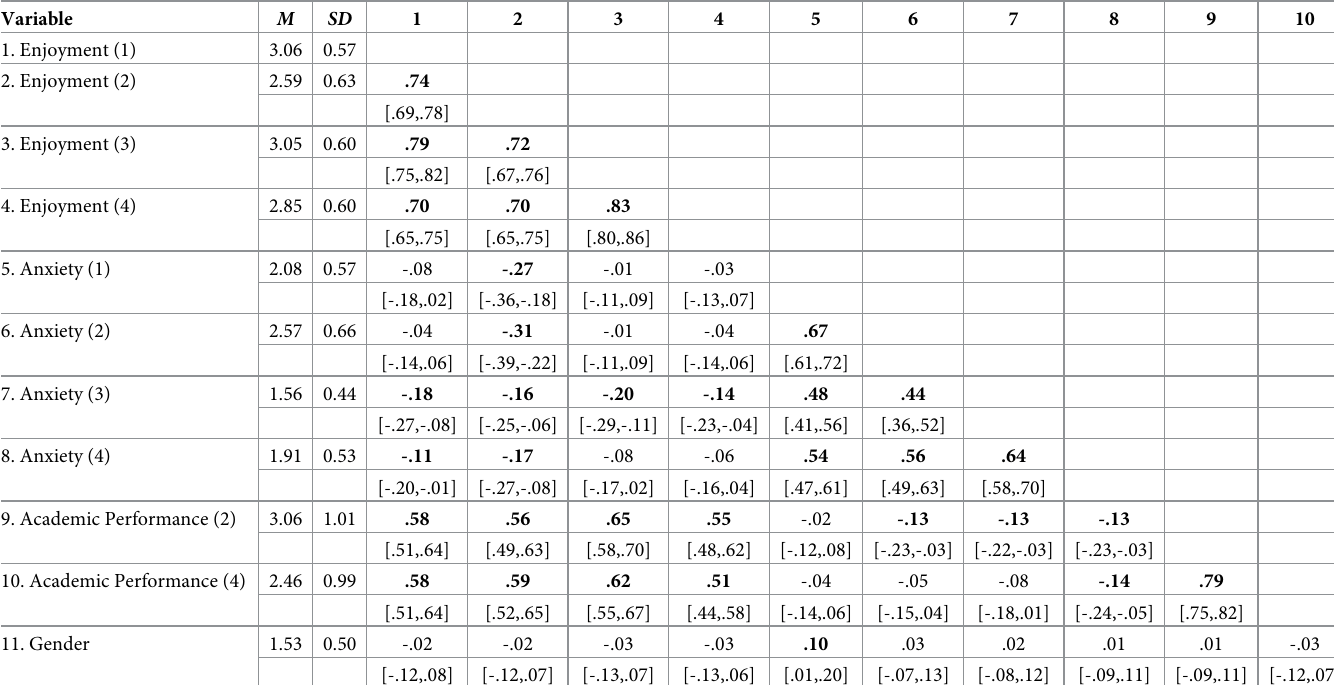
Table 1. Descriptive statistics of main variables.